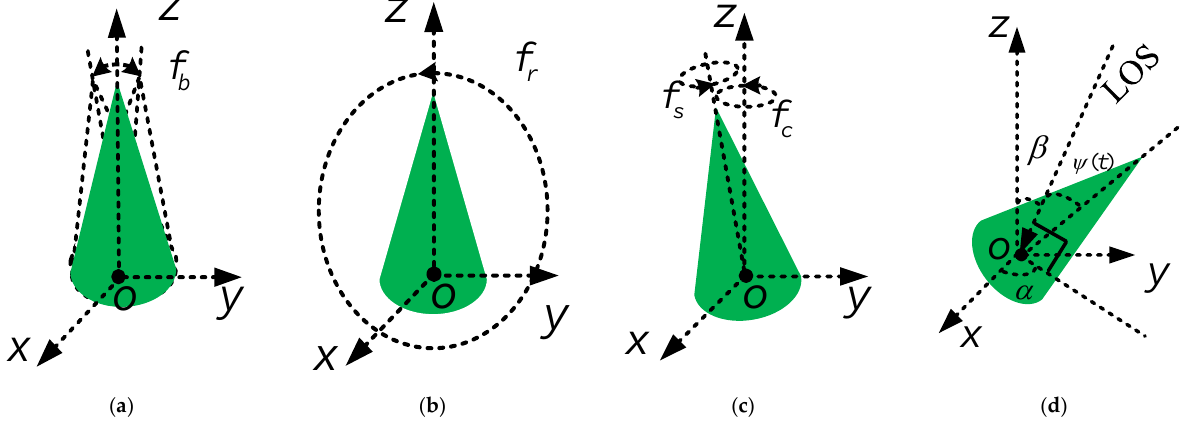
Figure 1. ( a ) Swing; ( b ) Rolling; ( c ) Precession; ( d ) Observation models of different micro-motions. Swing: As shown in Figure 1a, the target swings at a small angle along oz in yoz . Set the amplitude of swing as θ b , the initial phase as θ b _0 and the swing frequency as f b . Setting the angle between the symmetry axis and oz as ang sw ( t ) , we denote ang sw ( t ) as